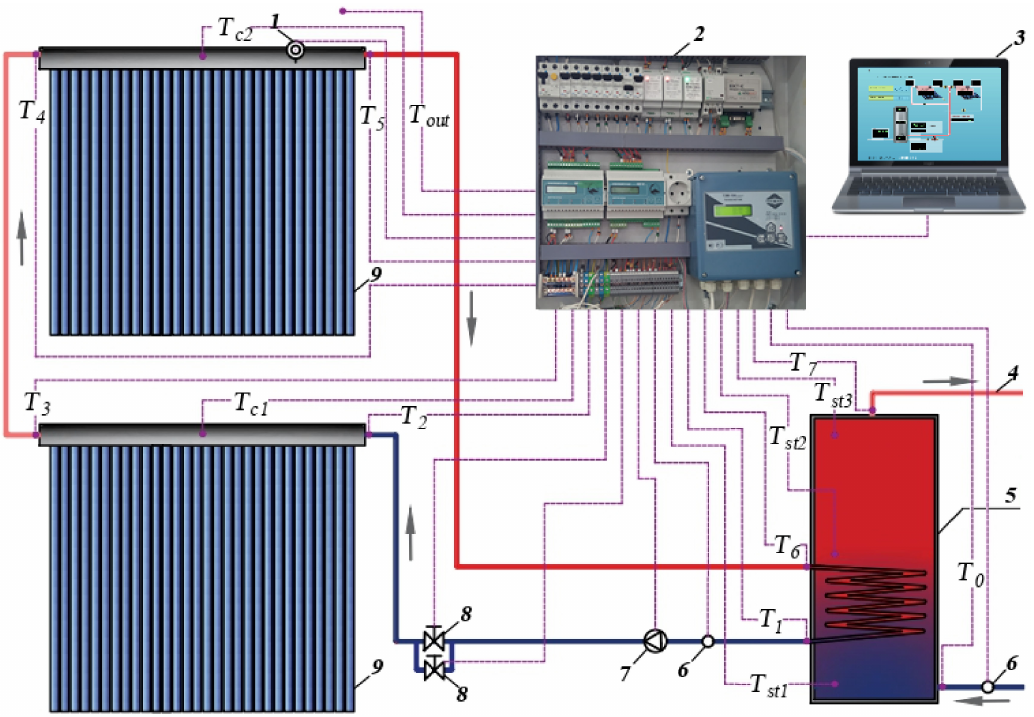
Figure 5. Main components and sensors of an experimental solar hot water system: 1 —solar insolation sensor; 2 —control unit with a device for collecting and transmitting data; 3 —server; 4 —pipeline for supplying heated water to the consumer; 5 —storage tank; 6 —water flow meter; 7 —circulating pump; 8 —electromagnetic valve; 9